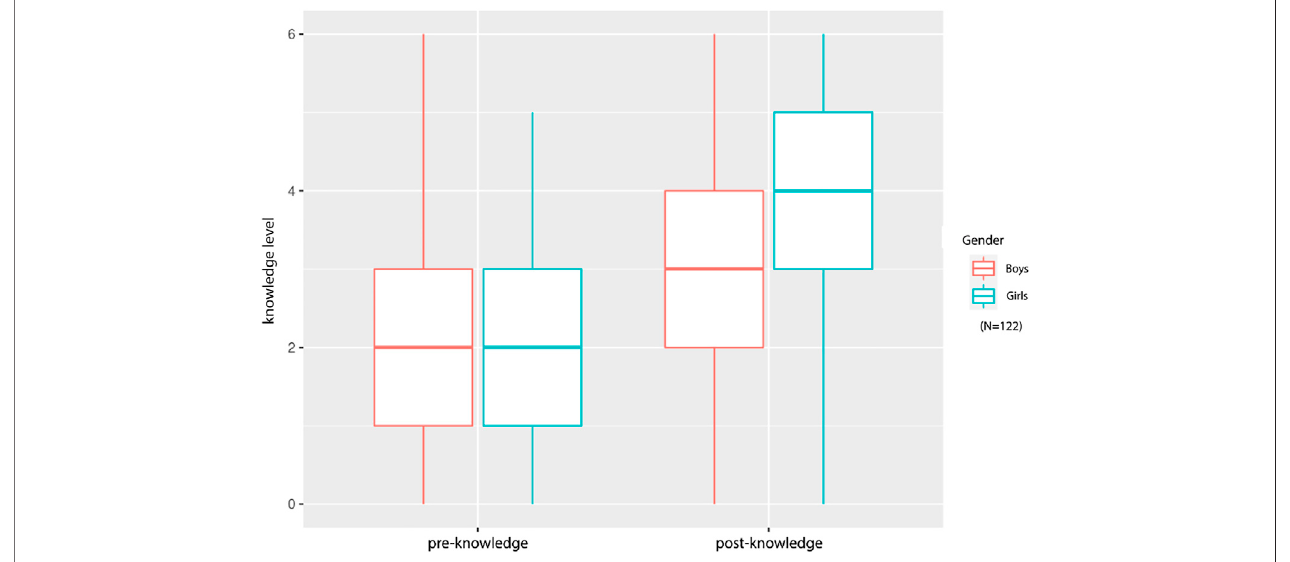
FIGURE 3 | Participants ’ pre- and post-knowledge average results by gender.